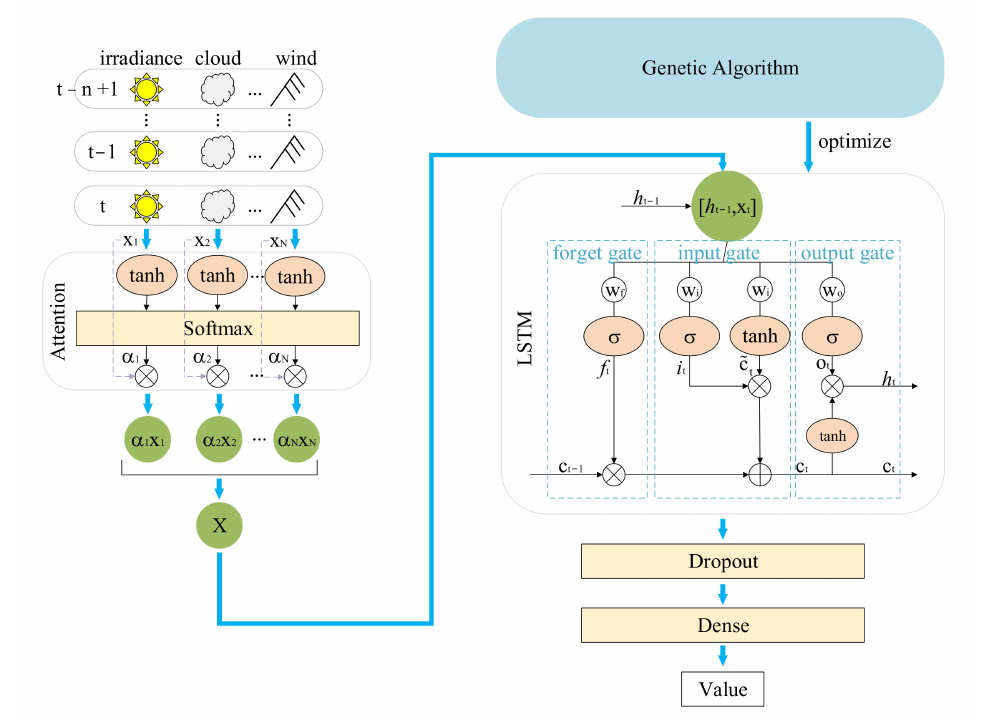
Figure 1. The prediction process of the AGA-LSTM